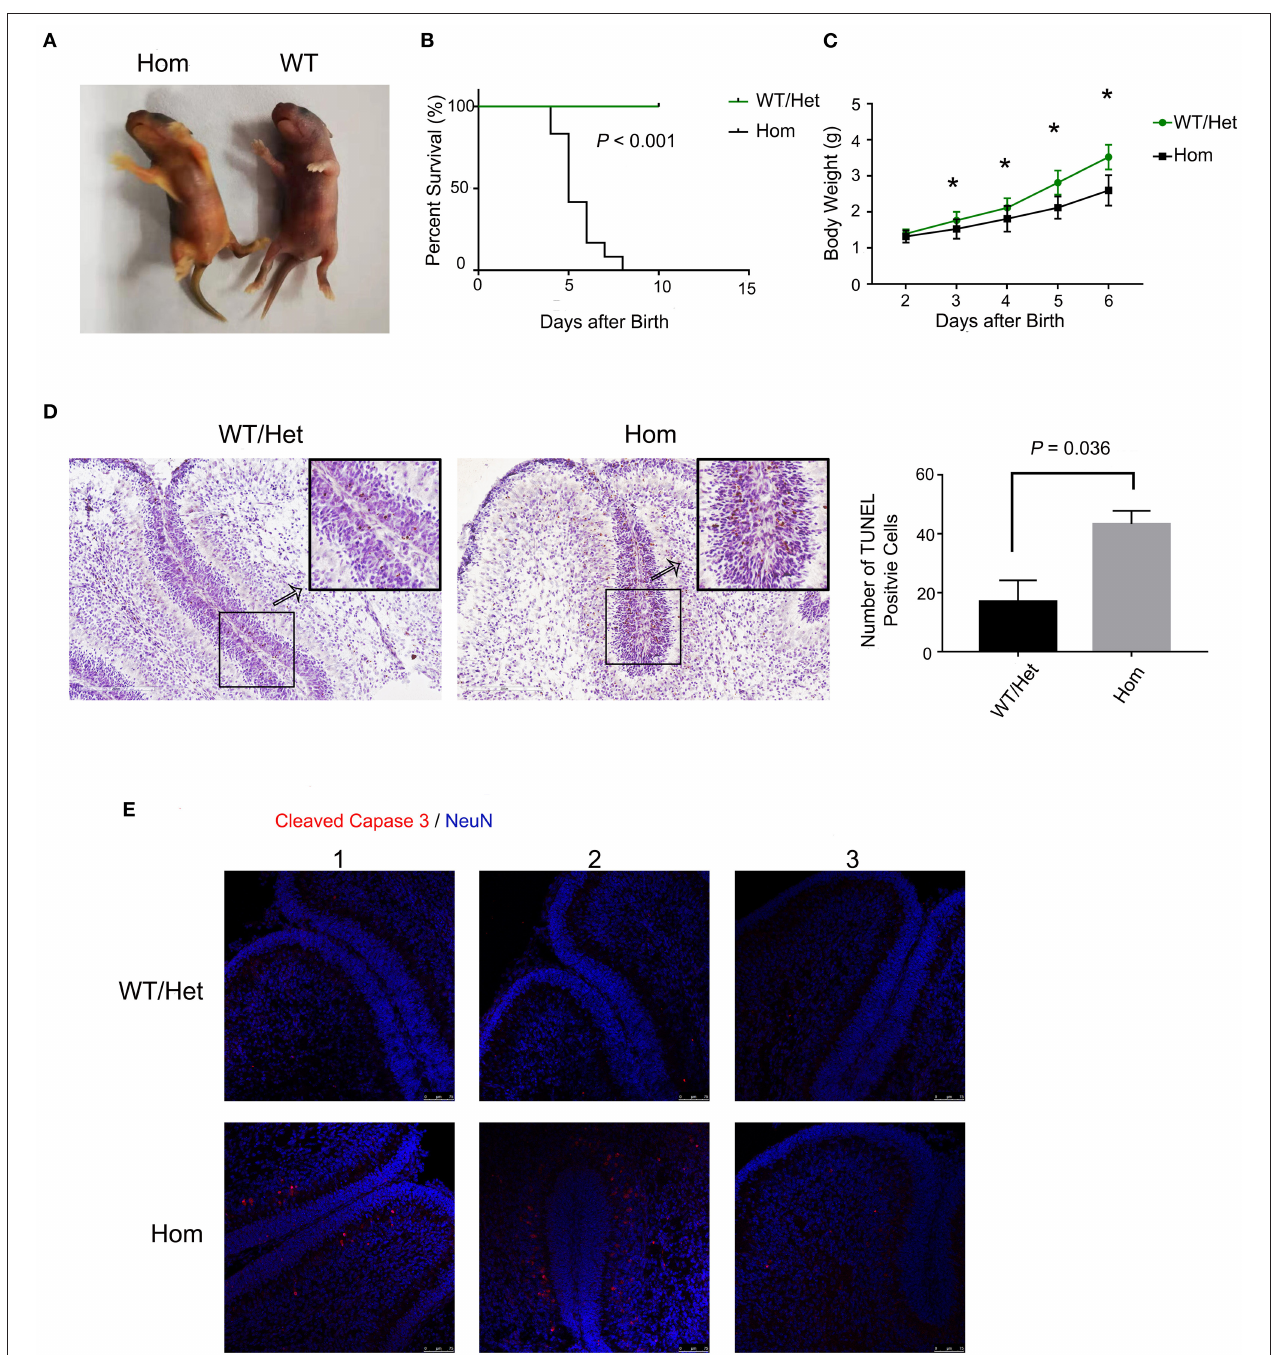
FIGURE 1 | Ugt1 mutation induces apoptosis of cerebellum cells. (A) Appearance of jaundiced Ugt1 − / − mice at P4. (B) Kaplan-Meier survival curves of Ugt1WT/Het mice ( n = 14) and Hom mice ( n = 12). (C) Comparison of body weight of Ugt1WT/Het mice ( n = 14) and Hom mice ( n = 12). Since all Hom mice died within 7 days after birth without any treatment, the statistic was done from P2 to P6 using t test. *represented P value of comparing body weight between the two groups on the same day after deliver ( P < 0.05). (D) Left panel, representative TUNEL images on the cerebellar frozen section at P4. Scale bar = 200 µ m. Right panel, TUNEL positive cells were counted from lobule 4 to lobule 6, t test was performed ( n = 3, respectively). (E) Representative fluorescent immunohistochemistry of cerebellar frozen sections with an anti-cleaved caspase 3 antibody (red) from WT/Het and Ugt1 − / − mice at P4 ( n = 3, respectively). DAPI (blue) was used to mark nuclei. Scale bar = 75 µ